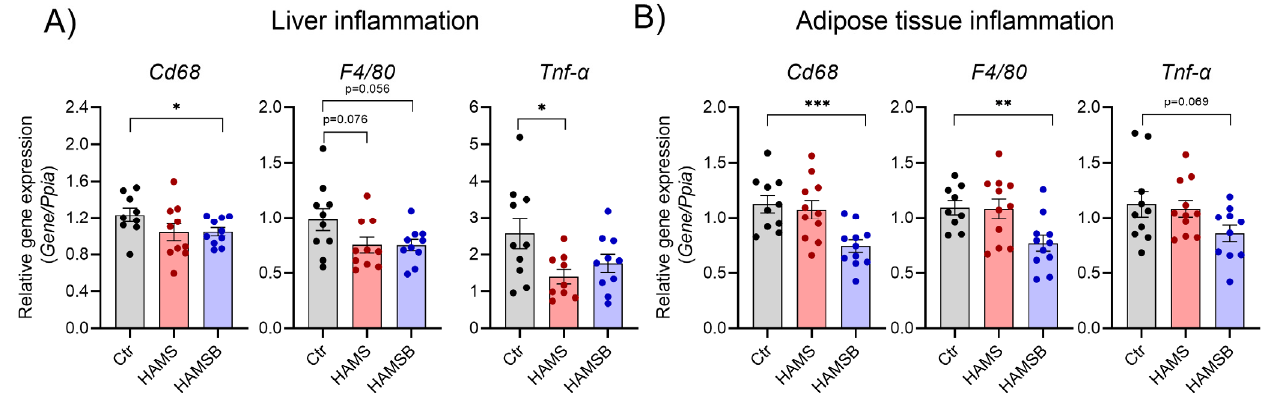
Figure 7. Inflammation in hepatic and adipose tissue. Inflammatory gene expression in the livers ( A ) and epididymal adipose tissue ( B ) of mice fed a Ctr, HAMS or HAMB diet for 5 weeks. Total RNA was extracted, and gene expression determined by RT-qPCR. Data are normalized to the reference gene Ppia . Bars show the mean ± SEM. * p < 0.05, ** p < 0.01, *** p < 0.001. Cd68 , cluster of differentiation 68 ; F4/80 encoded by Adgre1 , adhesion G protein-coupled receptor E1 ; Tnf- α , tumor necrosis factor α . Each circle represents pools of islets from mice.